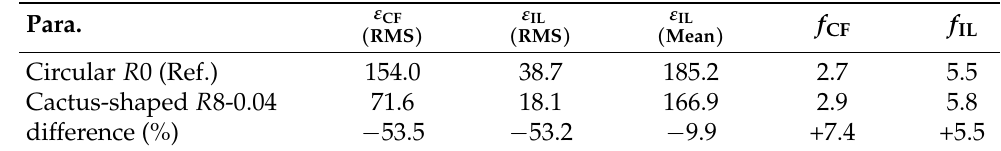
Figure 13. Micro-strains measured in the CF- and IL-directions at the mid-span location of a single flexible pipe installed with a circular sleeve, R 0, and compared with those of a cactus-shaped sleeve, R 8-0.04. Table 4. VIV responses of a single flexible pipe with a different cross-sectional shape: circular R 0 vs. cactus-shaped R